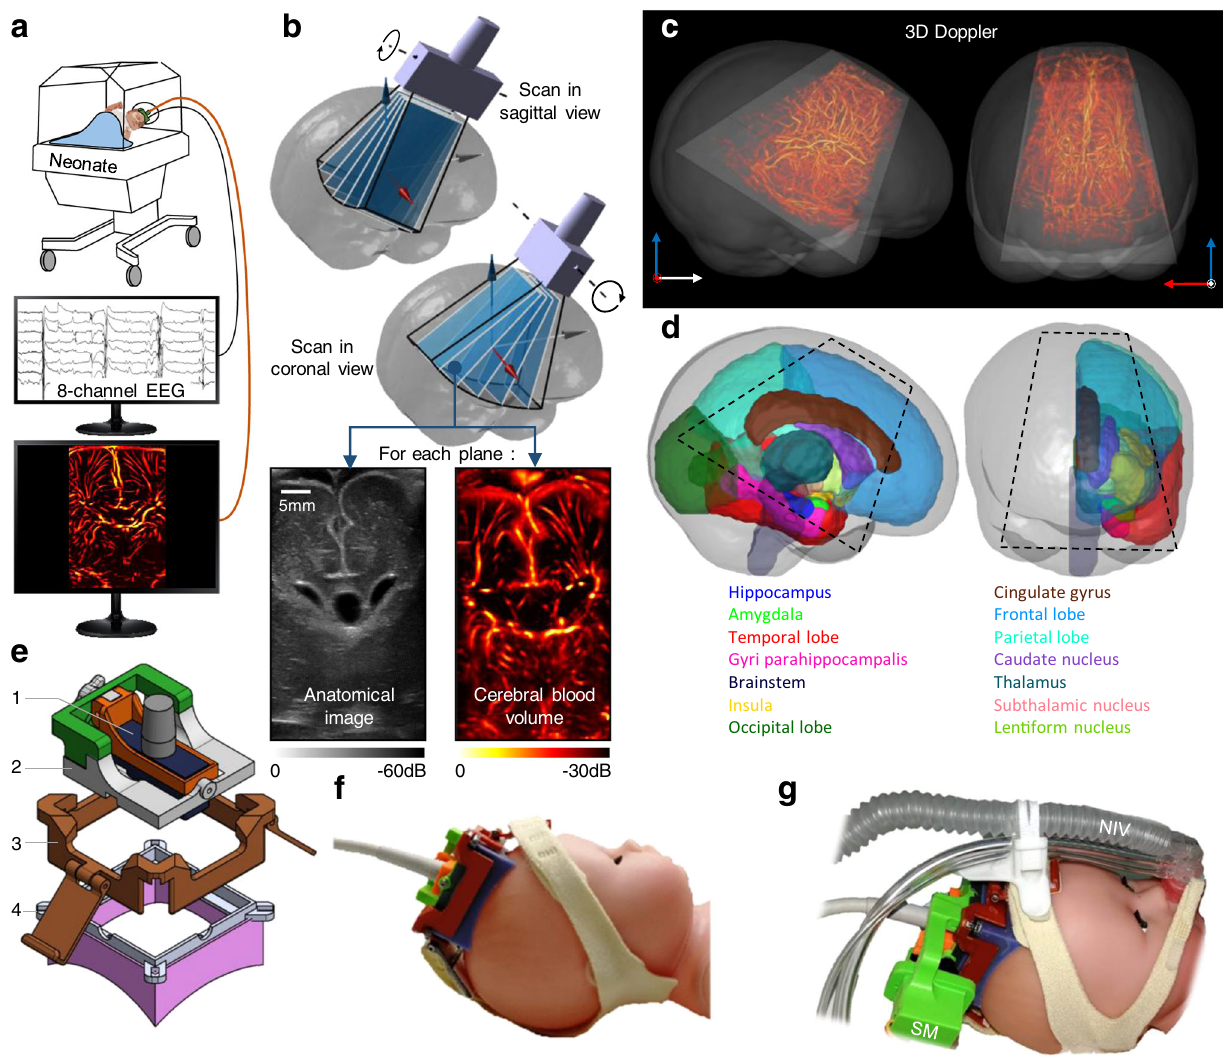
Fig. 1 fUS recording and brain atlas registration. a Simultaneous acquisition of an eight-electrodes EEG and fUS on neonates kept in their incubators. b 3D ultrasound tomography combining motorized plane-by-plane scans in coronal and sagittal views. The anatomic B-Mode image and the vascular doppler image are acquired in each plane. Only one scan in each orientation was needed for each patient. c In dark gray, sagittal and coronal view of a MRI T1 volume of a 28 weeks PMA preterm neonate. Trapezoid in light gray: brain volume accessible with fUS. In red, the 3D vasculature from Doppler tomography is overlaid. d Brain areas in the right hemisphere of a 28 weeks PMA preterm neonate, segmented according to Makropoulos atlas. Dashed black lines demarcate the ultrasound-accessible structures. e Detail of the 3D-printed headset. (1) Ultrasound probe. (2) Probe-holder with rotation axis. (3) Straps holder. (4) Cap with magnets to secure the probe-holder, and silicon casting adapted to the patient skull. f Ultrasound probe inserted in the headset, and secured to the model head using headgear ’ s straps. g Motorized version of the probe-holder with as servomotor (SM), compatible with the non-invasive ventilation system (NIV) commonly used on very preterm